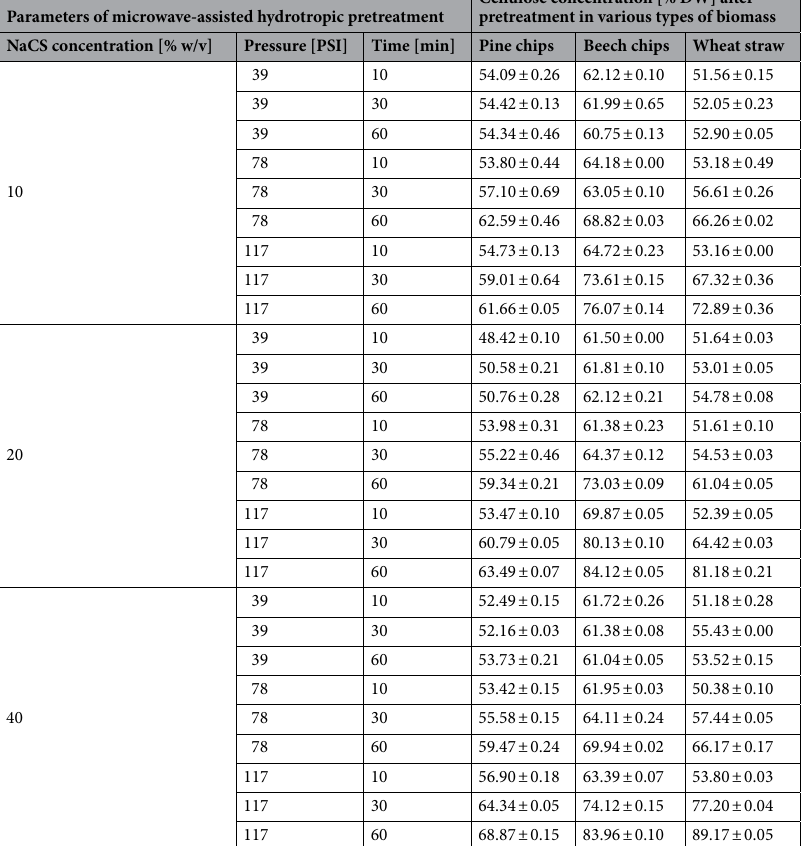
Table 1. Cellulose concentration in various types of biomass after microwave-assisted hydrotropic